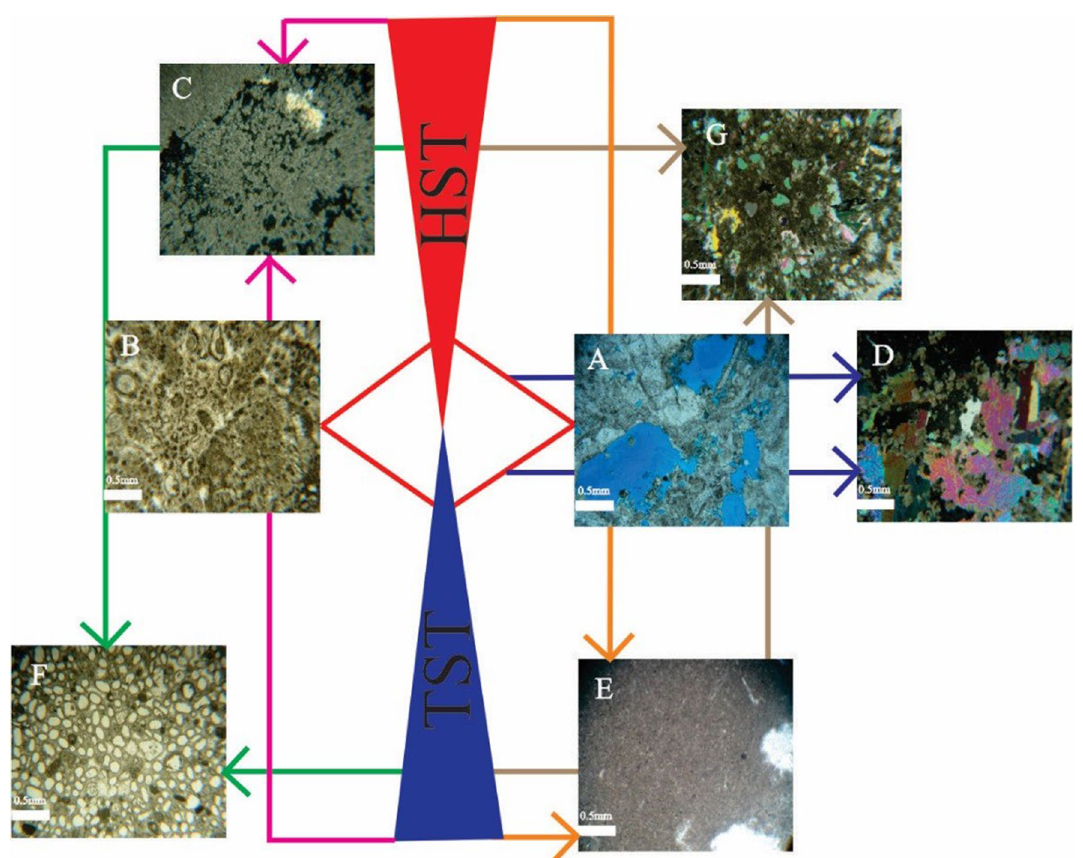
Fig. 12 Sequence position of various HFUs. a HFU1: vuggy grain- stone facies at late TST or early HST, b HFU2: grainstone facies at late TST or early HST, c HFU3 with mudstone facies has perme- ability 10–100 mD at early TST or late HST, d HFU3 and HFU4: cemented grainstone facies has permeability lesser 10 mD at late TST